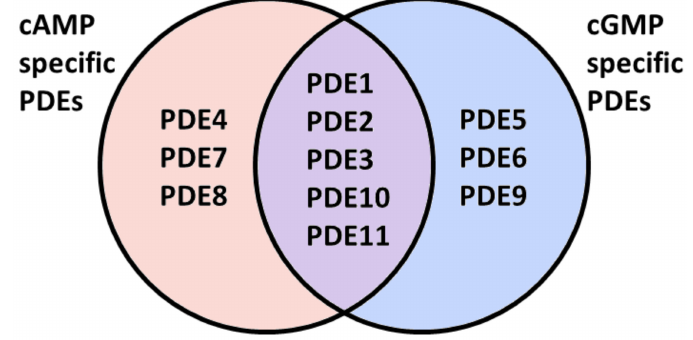
Figure 2. Substrate specificity of individual phosphodiesterase (PDE) families.